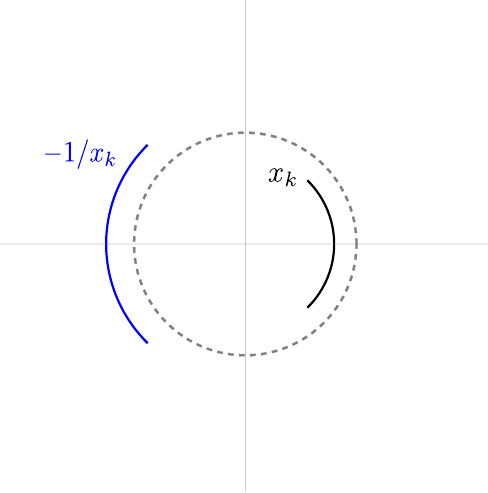
Figure 7 . Analytic structure of p L ( x ). In the semi-classical limit, the function p L ( x ) has two branch cuts; the one coming from the condensation of x k and the other coming from the condensation of 1 =x k